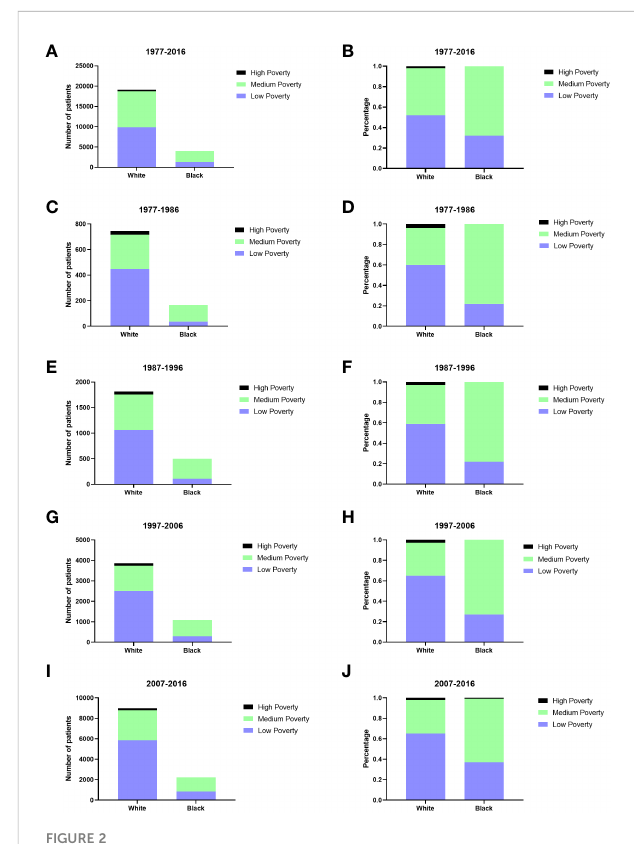
FIGURE 2 The numbers of patients with GI-NETs of SES in different races across four decades (A, C, E, G, I) ; Changes in the distribution of SES in different races across four decades (B, D, F, H, J) .